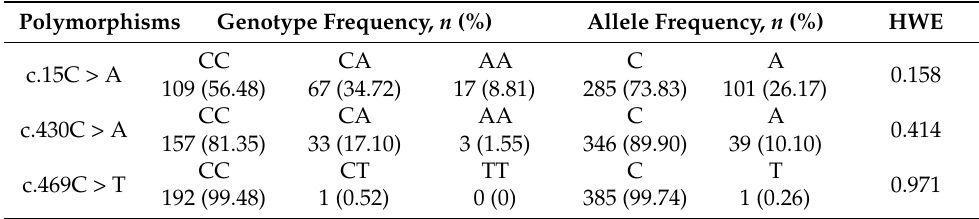
Figure 1. Novel genetic polymorphisms in the feline shadow of prion protein gene ( SPRN ) in the present study. ( A ) Gene map of polymorphisms in the feline SPRN gene on chromosome D2. The open reading frame (ORF) is indicated by a shaded block, and the 5 ′ and 3′ untranslated regions (UTRs) are indicated by white blocks. The edged horizontal bar indicates the regions sequenced. ( B ) Electropherograms of 3 novel single nucleotide polymorphisms (SNPs) in the feline shadow of prion protein gene ( SPRN ) found in cats. The four colors of the peaks indicate each base of the DNA sequence (green: adenine; red: thymine; blue: cytosine; black: guanine). Table 1. Genotype and allele frequencies of shadow of prion protein gene ( SPRN ) polymorphisms in 193 domestic cats.